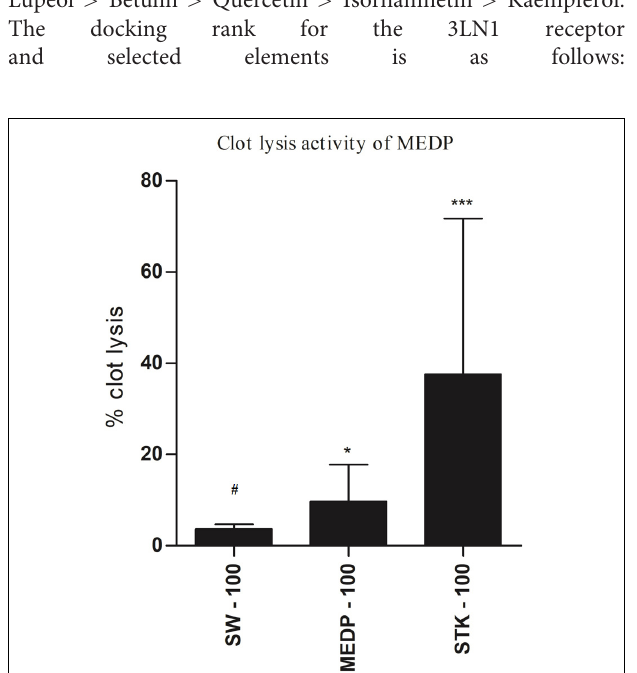
FIGURE 3 | Clot lysis effects by saline water, streptokinase, and MEDP. Anticoagulant values are presented as mean ± SEM ( n = 5); One-way ANOVA was followed by Dunnett’s test. * p < 0.05 and *** p < 0.001 were considered as significant compared with the control, where # is designated as control. MEDP = methanol extract of Dillenia pentagyna leaves, SW = saline water, SPK = streptokinase.